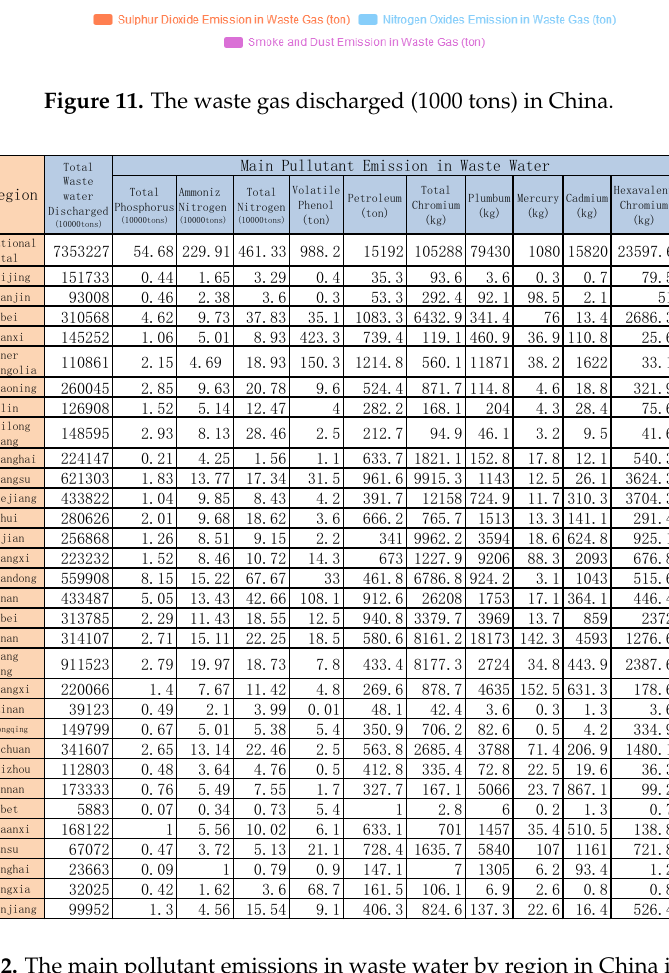
Figure 12. The main pollutant emissions in waste water by region in China in